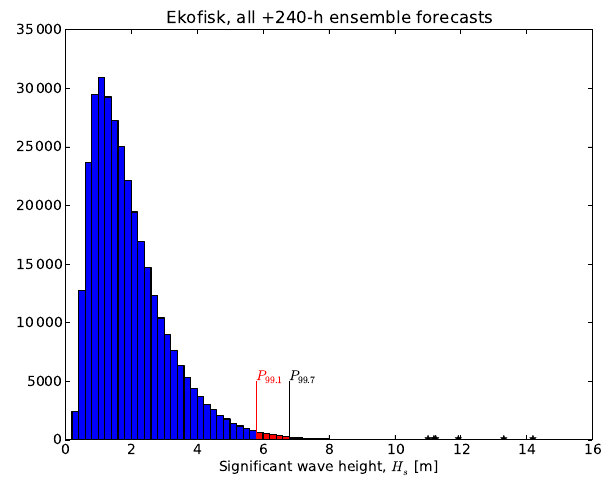
Figure 2. Histogram of the significant wave height from archived ensemble forecasts in the central North Sea (Ekofisk, 56.5 ◦ N, 003.2 ◦ E) at + 240h lead time. Entries above P 99 . 1 , corresponding to threshold U 0 , are coloured red whilst entries exceeding P 99 . 7 , corresponding to the upper threshold, u , are in black. The highest entries are individually marked with